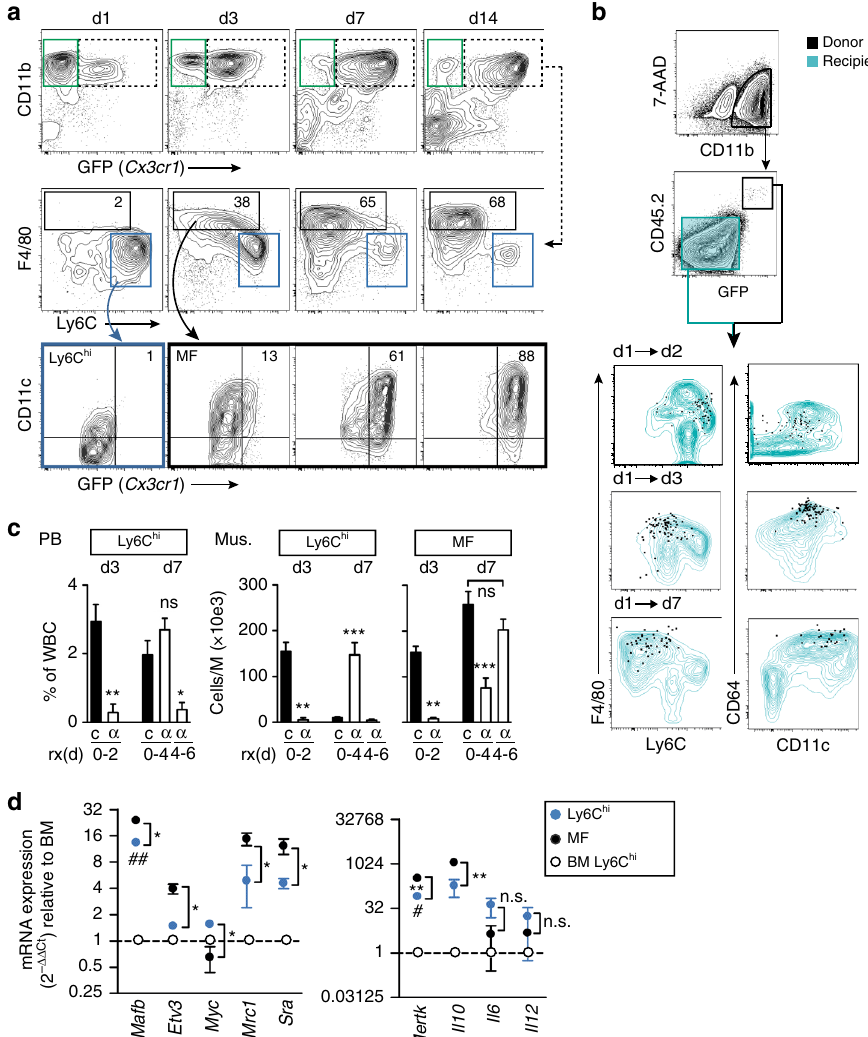
Fig. 1 Origin of macrophages in ischemia. a Representative fl ow cytometric analysis of ischemic tibialis anterior muscle of Cx3cr1 GFP/ + mice. Granulocytes (green), Ly6C hi monocytes (blue) and macrophages (black), n = 3 mice/group. b Adoptive cell transfer at d1 after HLI and cell fate tracking of CD45.2 + CD11b + GFP + Ly6C hi monocytes transferred into CD45.1 + recipients. Representative fl ow cytometry of recipient muscle, replicated at least three times. c Treatment with CCR2 blocking antibody MC-21 ( α ) or isotype control c for indicated time intervals (r × d) after HLI and analysis of cell populations in peripheral blood (PB) and muscle (M) by fl ow cytometry. n = 5/7/7 mice/group, error bars represent s.e.m. *** p < 0.001, ** p < 0.01, * p < 0.05 *indicates comparison between treatment with MC-21 ( α ) vs isotype control c by one way ANOVA with Bonferroni multiple comparison test. d Quantitative RT-PCR analysis of cell populations of Cx3cr1 GFP/ + mice sorted from d3 ischemic muscle relative to bone marrow (BM) Ly6C hi monocytes. n = 3 independent experiments, error bars represent s.e.m. *** p < 0.001, ** p < 0.01, * p < 0.05, # Comparison between muscle and BM Ly6C hi cells, *Comparison between muscle Ly6C hi and muscle macrophages (MF), one way ANOVA with Bonferroni multiple comparison